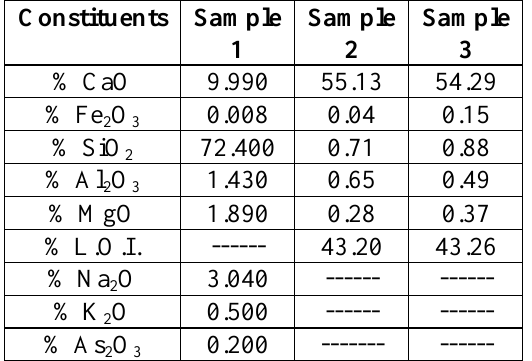
Table 2: Chemical analysis of the three different sample of